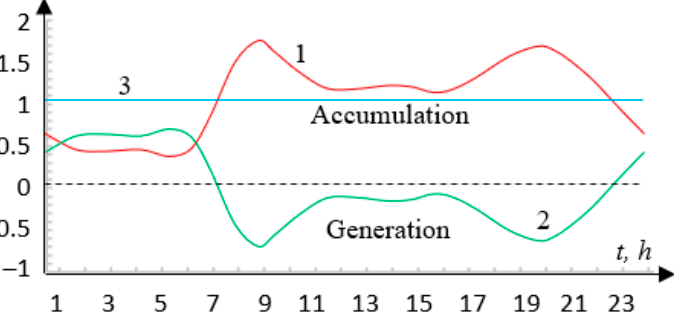
Figure 1. Dependence graphs for normalized capacities: 1 —graph of the electricity consumption function Pp.nor(t) ; 2 —graph of the function for ESS Pp.nor(t) ; 3 —the graph of the function of the sum of the powers of all generators Pg.nor(t) = 1.